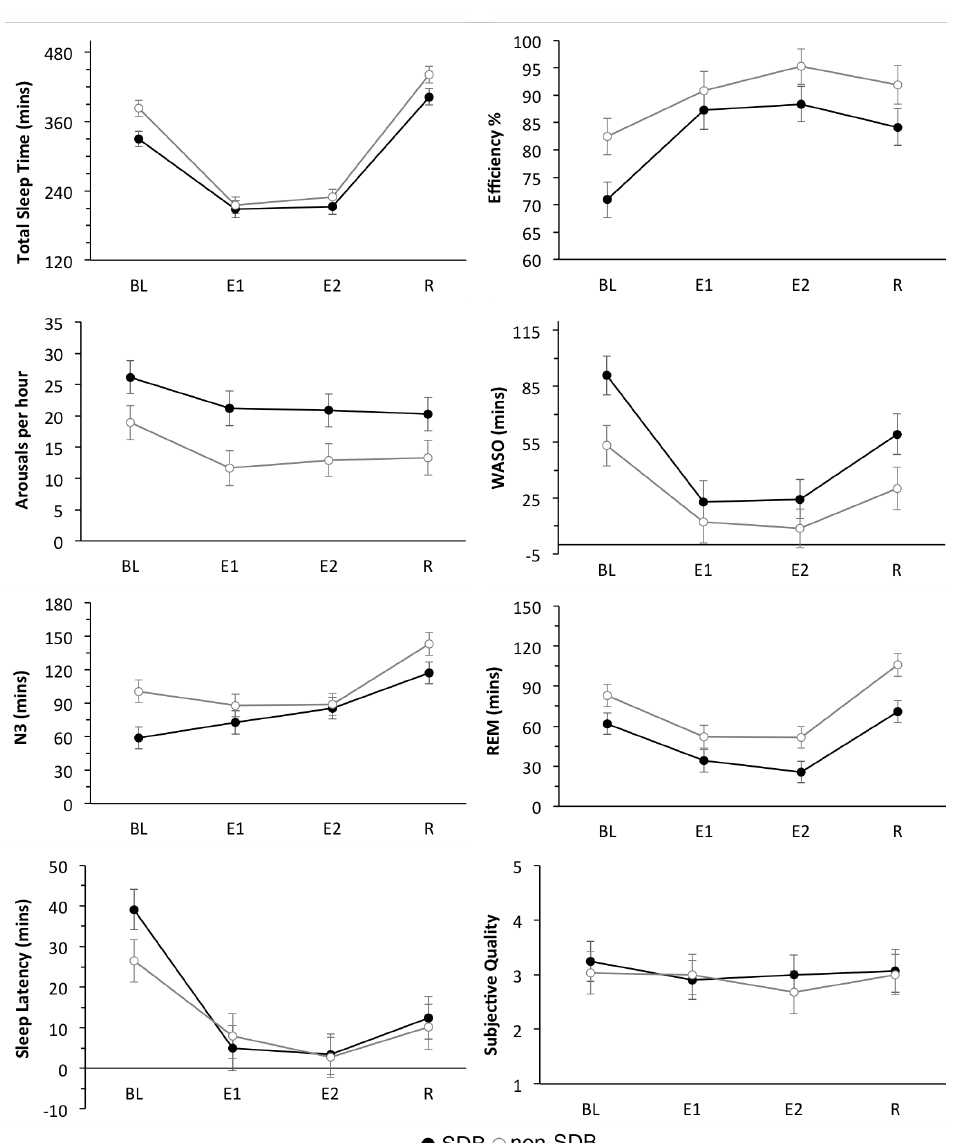
Figure 1. Sleep Variables. Mean ± Standard error or measurement (SEM) for TST, Efficiency, Arousals/h, WASO, N3, REM, SOL, Subjective Sleep Quality for the two groups: SDB, non-SDB and across the 4-nights: Baseline (BL), Experimental Night 1 (E1), Experimental Night 2 (E2) and Recovery (R).